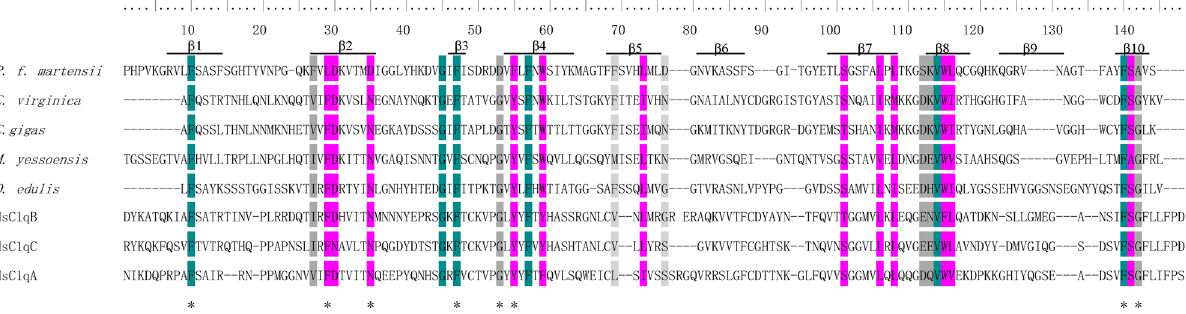
Figure 1. Multiple-sequence alignment of C1q-domain. *The eight conserved residues in the human gC1q domain; the blue background indicates conserved aa; the pink background indicates aa with strong similarity; the gray background indicates aa with weak similarity; the top numbers show the position of sequence alignment aa. The accession numbers of the sequences used in this alignment are as follows: C. virginica